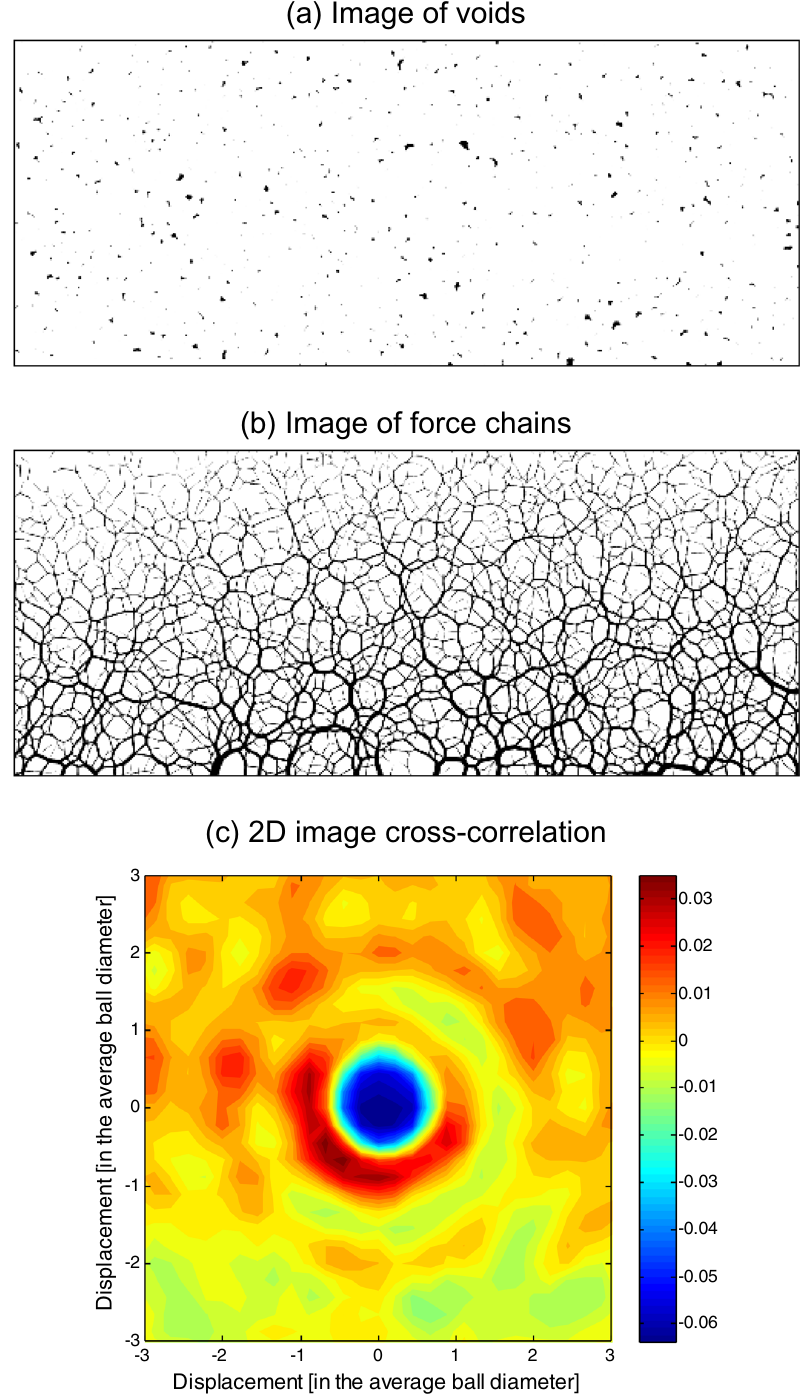
Figure 7. Causal link between ( a ) large remnant voids and ( b ) force chains; ( c ) 2D cross-correlation shows that large voids remain within a grain diameter from major force